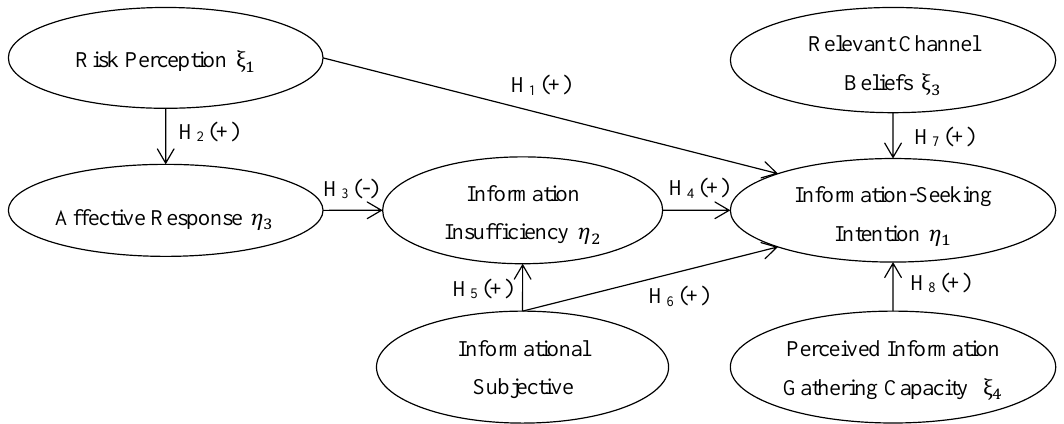
Figure 1. RISP model framework and research hypotheses. Notes: η 1 , η 2 , and η 3 are latent variables as outcomes; ξ 1 , ξ 2 , ξ 3 , and ξ 4 are latent variables as causes; H 1 –H 8 are tested hypotheses with ‘ + ’ sign inside parentheses indicating a positive relationship between two latent variables and ‘ − ’ sign inside parentheses indicating a negative relationship between two latent variables.